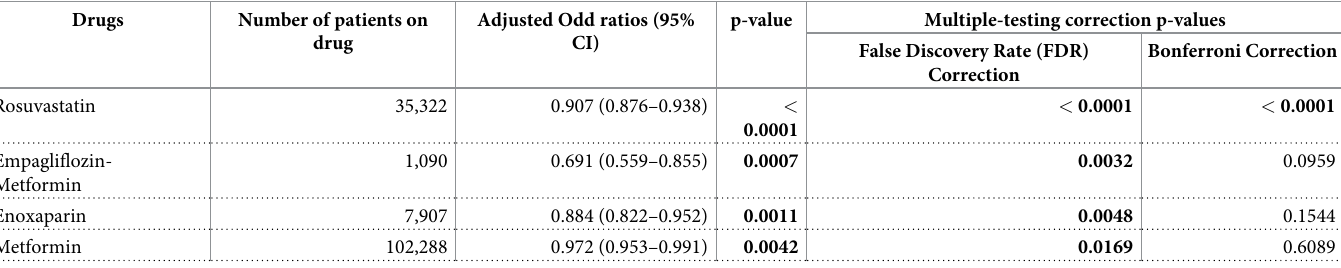
Table 3. Drugs found to be statistically significant (p < 0.05) in preventing hospitalization due to COVID-19: Number of patients on drug, adjusted odds ratios, p- values, and Bonferroni 95% confidence intervals for drugs. Statistically significant results (p < 0.05) are